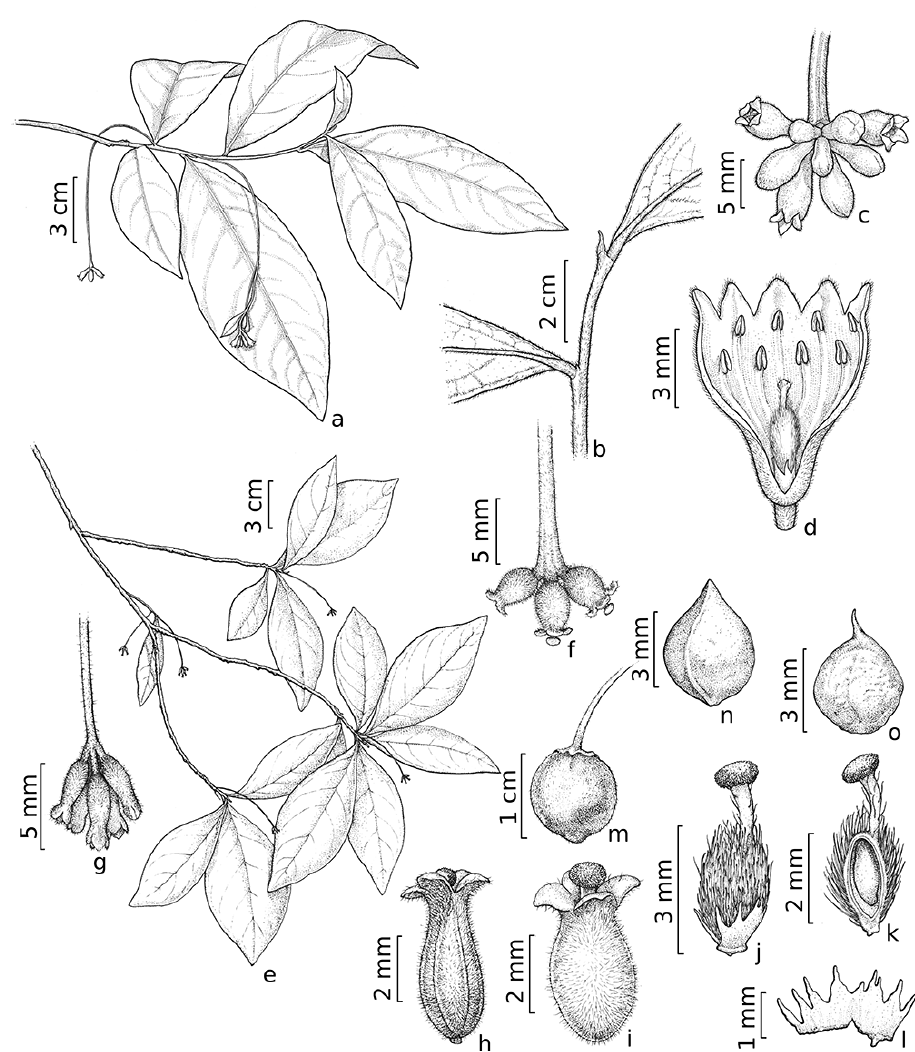
Figure 1. Daphnopsis filipedunculata Nevling & Barringer, male individual ( A–D ) and female individual ( E–O ). A staminate flowering branch B base of leaf blade C detail of inflorescence with staminate flowers D dissected staminate flower with two whorls of stamens and one pistillode E pistillate flowering branch F detail of inflorescence with three pistillate flowers (fresh material) G detail of inflorescence with five pistil- late flowers (dry material) H pistillate flower (dry material) I pistillate flower (fresh material) J Pistil with disc K dissected pistil, longitudinal cut of the ovary showing pendulous ovule L details of the lobed disc in female flower M fruit N seed O embryo. Drawn by João Silveira ( A−D modified from Mota and Giulietti 2016) ( E, G−H, J−L, N−O Watanabe et al. 485 , F, I, M Santos et al. 395 and 396